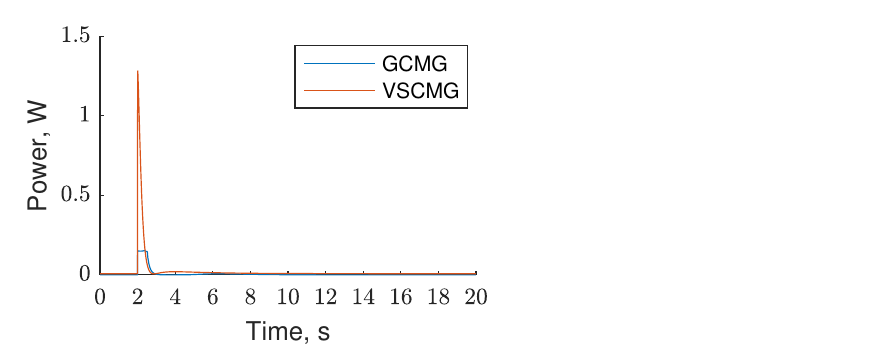
Figure 9. Power profile for GCMG and VSCMG cluster. Table 5. Power